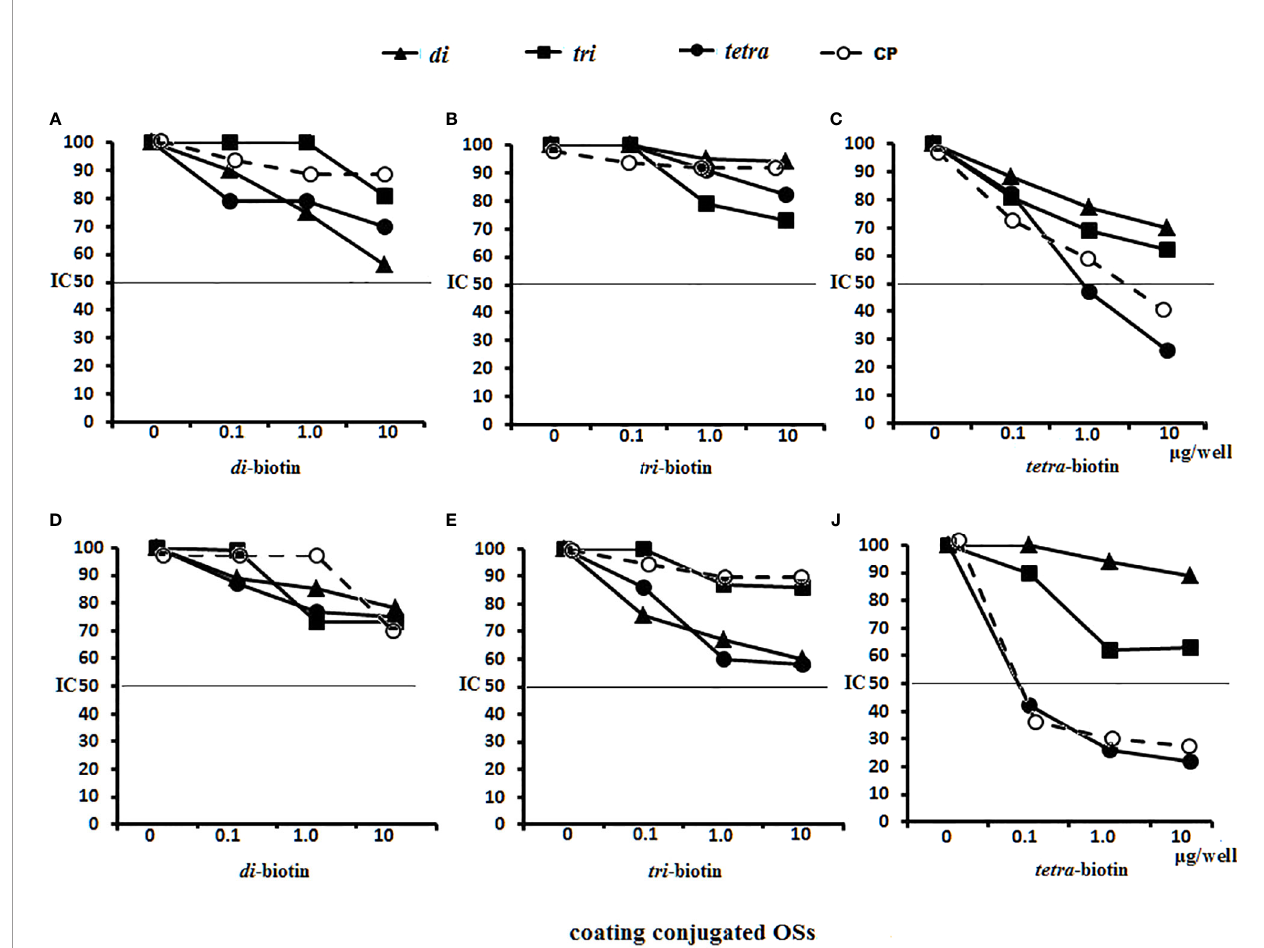
FIGURE 8 | Inhibition of anti-OSs IgG1 antibodies (Abs) in mice and rabbit immune sera with OS ligands and CP. (A – C) Inhibition of IgG1 Abs in the pooled sera of BALB/c mice (n = 6 for each glycoconjugate) (A) Di – BSA conjugate antiserum in 1:500 dilution was tested against di – biotin capture material. (B) Tri – BSA conjugate antiserum in 1:500 dilution was tested against tri – biotin capture material. (C) Tetra – BSA conjugate antiserum in 1:1,000 dilution was tested against tetra – biotin capture material. (D – F) Inhibition of IgG Abs in the pooled sera of rabbits (n = 2) immunized with inactive S. pneumoniae type 3 cells. Dilution of sera tested